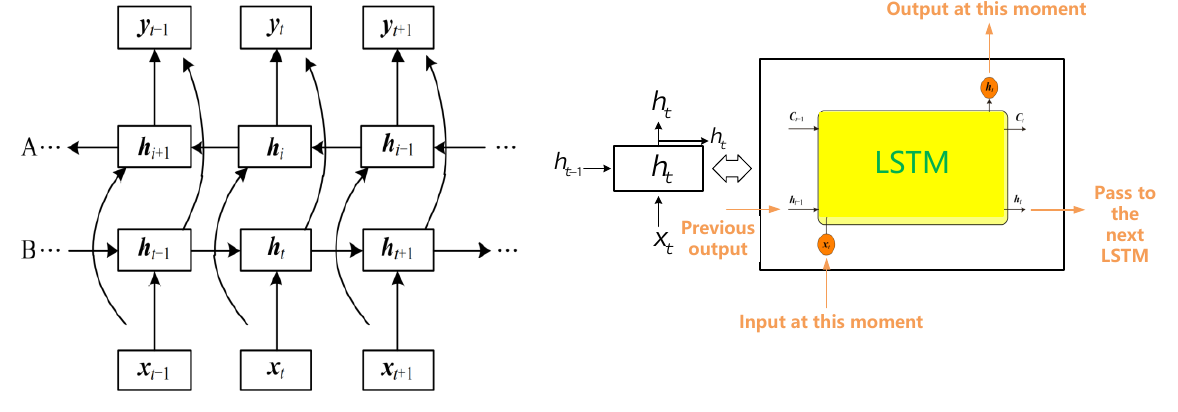
Figure 3. Bi-LSTM structure. For Bi-LSTM networks, the hidden layer state h t of each level is superimposed by three parts [28]. The output state h t − 1 of the hidden layer at the previous moment propagating in the forward direction along the time axis. The output state h i − 1 of the hidden layer at the previous moment propagating in the reverse direction along the time axis, and the input amount x t at the current moment. The combined process of each hidden layer state can be represented by Equations